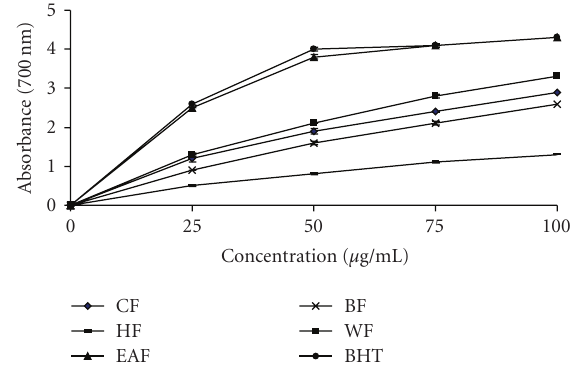
Figure 4: Reducing power activity of the crude ethanol fraction (EF), hexane fraction (HF), ethyl acetate fraction (EAF), butanol fraction (BF) and water fraction (WF) from wampee peel. Higher absorbance value indicates higher antioxidant